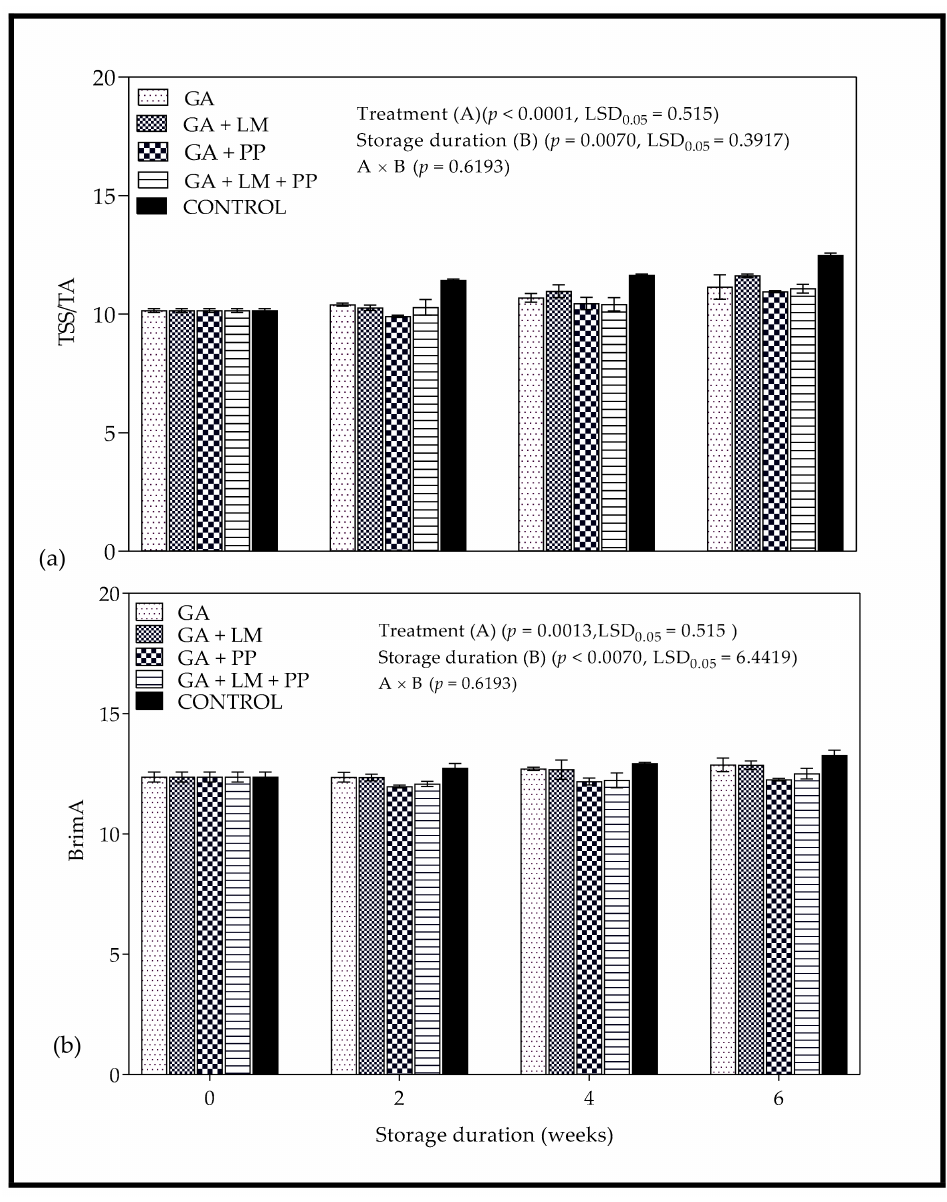
Figure 9. ( a ) TSS/TA and ( b ) BrimA of ‘Wonderful’ pomegranate whole fruit coated with gum arabic (GA) coatings enriched with lemongrass oil (LM) (0.1% v/v ) and/pomegranate peel extract (PP) (1% w/v ) and stored at 5 ± 1 ◦ C (95 ± 2% RH) for 6 weeks followed by 5 d at shelf-life conditions (20 ± 1 ◦ C and 60% RH). Vertical bars represent the standard error (SE) of mean values calculated from three measurements (Aril juice extracted from 10 fruit = 1 replicate = 1 measurement). LSD 0.05 represent least significant difference ( p <